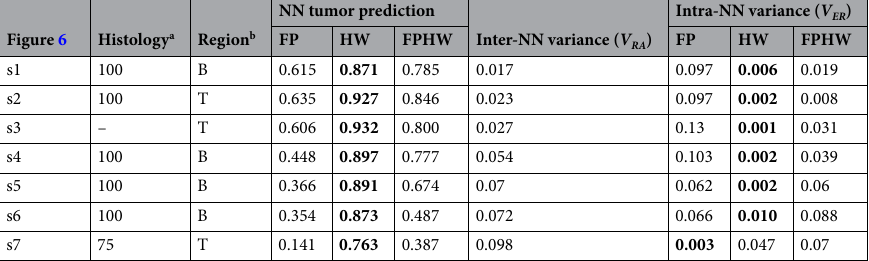
Spectra s5, s6, and s7 triggered a low-level warning in FP ( P Tumor ~ 0.6). These spectra show increases in signal strength at 796 and 828 cm −1 , indicative of cellular increases in nucleic acids and proteins. Spectra s4, s5, and s7 contain narrow peaks of activity expected from surgical marking dyes at locations that do not compromise the nine NN diagnostic bands. Seventeen targets (Fig. 5B, yellow shading) exhibit high V RA (> 1σ), but low V ER (< 1σ). See Table S2in Supple- mentary material for P Tumor , V RA , and V ER values. For these targets there is high agreement amongst the three nets, but none of them are very certain of their decision. All targets were from tumor or border regions. Compared to the 7 targets in Table 6 (the red zone of Fig. 5B) these NNs show more individual variation (higher V RA ), less disagreement (lower V ER ), and lower P Tumor estimates. No NN configuration predicted tumor for all 17 targets. All three NN configurations agreed in their prediction of tumor for 6 samples (highlighted in bold). All three NN configurations also agreed when they predicted no tumor likely for 7 samples. In the remaining 4 samples at least one NN configuration predicted tumor, but probabilities were quite low ranging from P Tumor ~ 0.505 to 0.634. Figure 7 shows a laser spot size of 85 μm diameter (the dotted red rings) superimposed on 100 × 100 μm regions from healthy, boundary, and tumor zones. The inset shows the location (black arrow) of the regions on the H&E slide. The scale bar in the lower left corner of each image denotes 20 μm. Paraffin-filled white spaces (L) are lipid-rich in vivo. In the first image, healthy cells are surrounded by protein-rich supporting stroma (P). Cell nuclei (N) rich in DNA, RNA, and peri-nuclear proteins occur infrequently in these healthy regions and then increasingly dominate in boundary and tumor zones. From the geometric constraints depicted in these images it appears that spectral mixtures of healthy and tumor signals can be expected to occur quite frequently when probing heterogenous, rapidly progressing tumors. Hence, probabilistic algorithmic outputs were chosen to represent the likely detection of a cluster of mixed cells. The final statistics and spectra identified by the autonomous, probabilistic artificial intelligence techniques employed in this study are presented in Table 7. Table 7 shows the autonomous classification of the 154 spectra for which we have H&E quintile assignments. Here the spectra from the original five (5) histopathology quin- tiles have been re-binned according to the maximum probability predicted by any one the three NNs (FP, HW, FPHW) when classifying the full data set (n = 203, 8 patients). The Bayesian probability quintiles are equal range bins: 0.0 ≤ P < 0.2; 0.2 ≤ P < 0.4; 0.4 ≤ P < 0.6; 0.6 ≤ P < 0.8 and 0.8 ≤ P ≤ 1.0. The mean spectra corresponding to these quintiles appear in Fig. 8. 147 of 154 spectra (95.4%) were assigned to end member quintiles: 0.0 ≤ P < 0.2 (N = 53, tumor unlikely) and 0.8 ≤ P ≤ 1.0 (N = 94, tumor highly likely). No targets received a probability score in the 0.6 ≤ P < 0.8 range. 24 of 25 spectra (96%) classified by histopathology as healthy did not receive a cancer prediction > 0.2 from the autonomous classification. The one spectra in the 0.2 ≤ P < 0.4 bin received a maxi- mum score of P = 0.21. For the 49 spectra obtained from regions deemed 100% tumor-rich by histopathology, 45 (91.8%) were placed in the highest probability quintile 0.8 ≤ P < 1.0 bin. Two spectra were considered highly likely to originate in healthy tissue (0.0 ≤ P < 0.2) and two others appeared in the 0.2 ≤ P < 0.4 bin. The average spectra for each of the other four probability quintiles appear in Fig. 8. Maximum signal separation occurs with bands for the DNA|RNA signal at 796 cm −1 , the protein band at 828 cm −1 , the lipid signal at 1437 cm −1 and the three HW bands. The data presented here indicate that a panel of unsupervised, autonomous, stochastic nonlinear neural networks trained on both broad and focused infrared laser Raman spectroscopy data, can provide an operating